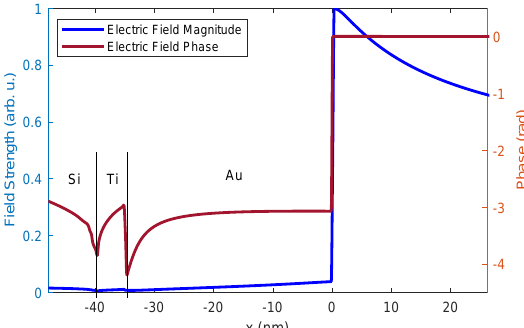
Figure 3. FDTD simulation of our Si-Ti-Au nanoblade. The peak field magnitude (blue) is mostly constant within the metal and follows a near 1/ r profile outside the metal. The phase (red) includes a π phase shift into the metal and some interesting behavior following. Our TDSE (time-dependent Schrödinger equation) simulations do not go far enough into the metal to include these effects as of yet. The first atomic layer is placed at x = 0 and so the surface of the metal is actually at x = x im in this